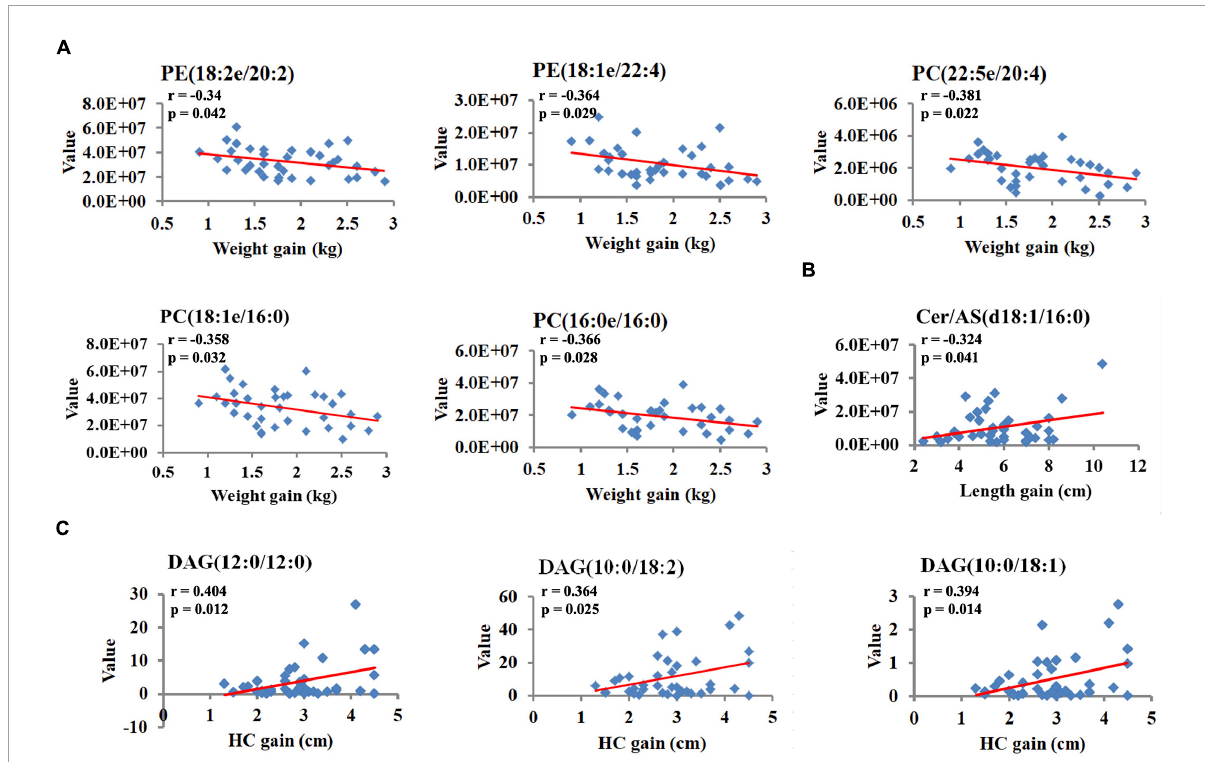
FIGURE6 Breast milk lipids are associated with indicators of infant physical development. (A) The correlation coefficients between breast milk lipids and bodyweight gain. (B) The correlation coefficients between breast milk lipids and length gain. (C) The correlation coefficients between breast milk lipids and HC gain. R and P -values presented are from Pearson’s